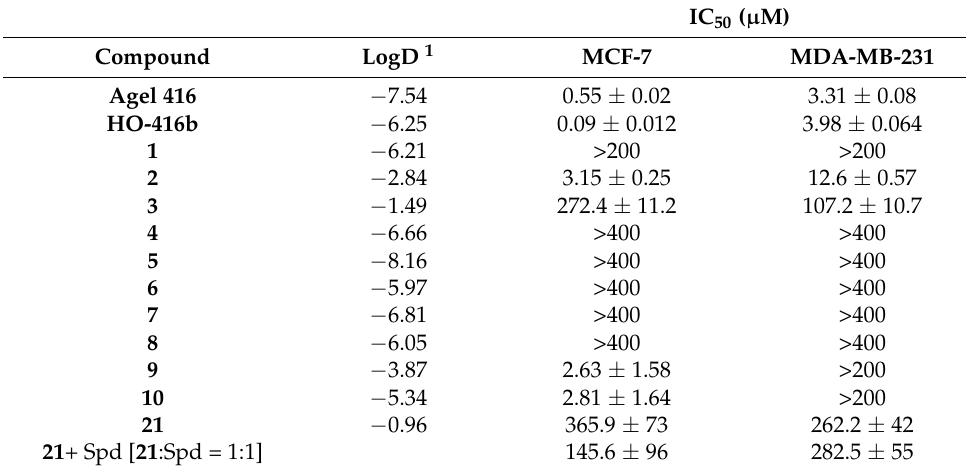
Table 1. Antiproliferative activity of synthesized PATs and analogs in the MCF-7 and MDA-MB-231 breast cancer cell lines. SD values are also provided for each IC 50 value.